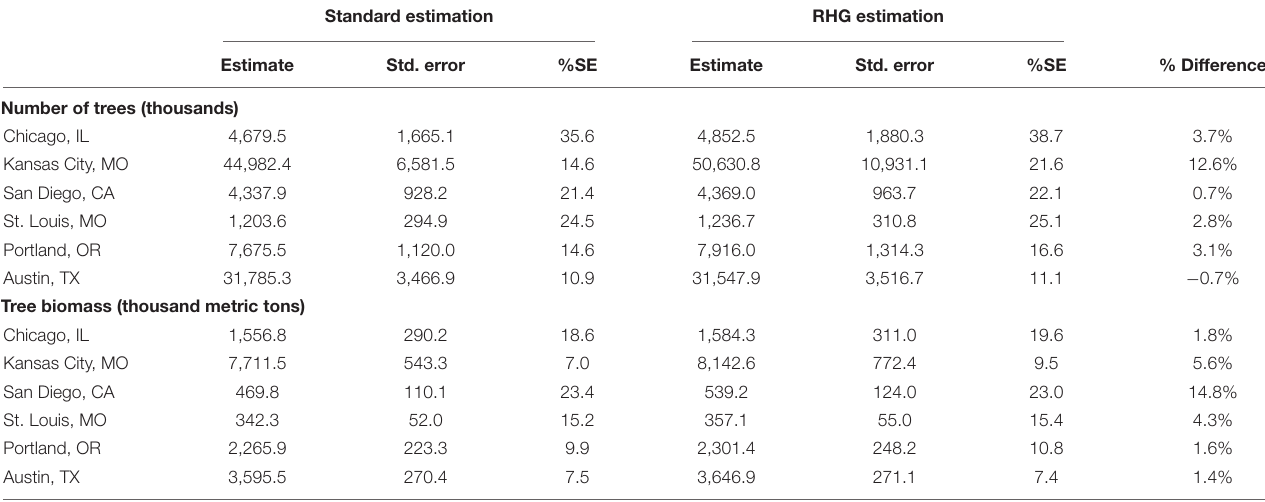
TABLE 3 | Summary of stratum and RHG statistics for Austin,